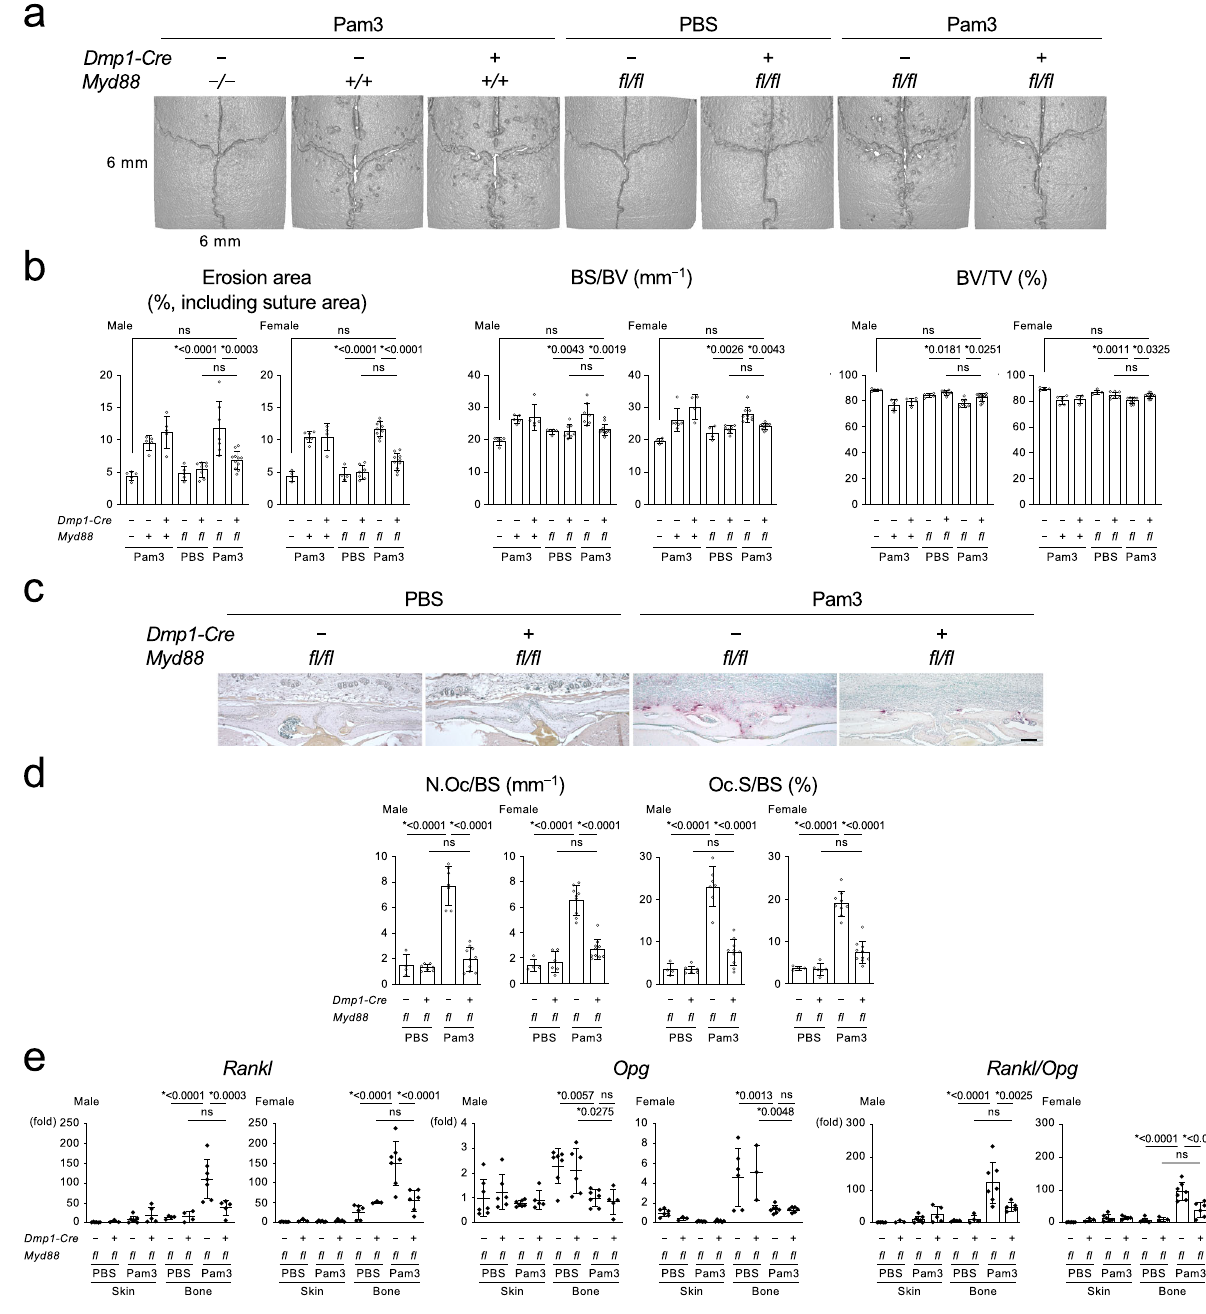
Fig. 1 | Lack of MYD88 in osteocytes and mature osteoblasts rescues calvarial osteolysis induced by Pam3CSK4 injection. a MicroCT images of the calvaria. Representativeimagesfromeachgroupofmalemice( n ≥ 5/group). b Erosionarea, BS/BV,andBV/TVofthecalvaria( n =5,5,5,5,8,7,11inmale, n =4,6,4,4,7,9,10in female). c TRAP staining of the calvarial bone. Representative images from each group of male mice ( n ≥ 4/group). Scale bar=100 μ m. d Histomorphometric